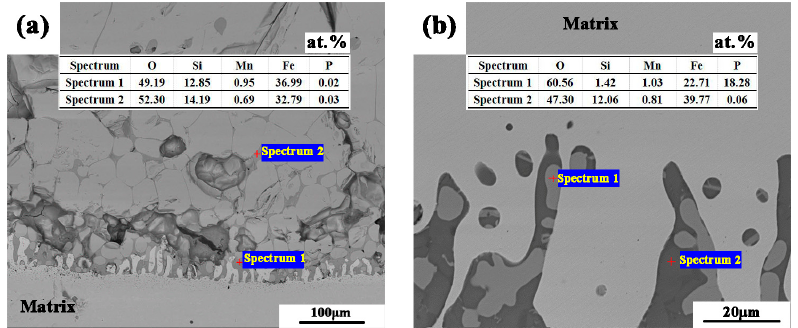
Figure 3. The distributions of chemical elements in the Fe 2 SiO 4 phase ( a ): SiP ‐ 1; ( b ): SiP ‐ 2.